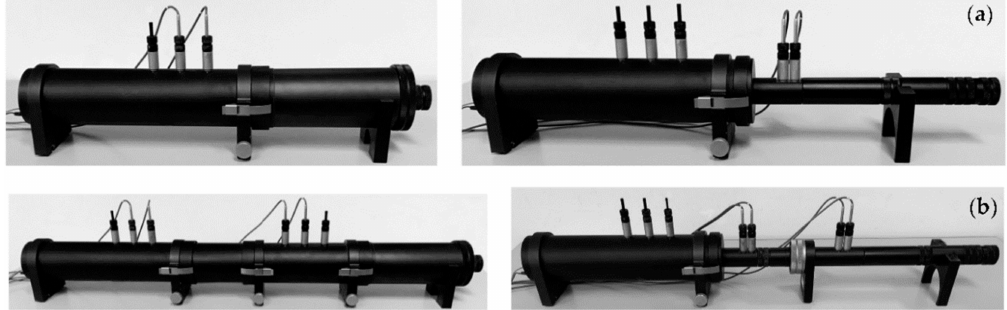
Figure 4. Normal incidence absorption coe ffi cient ( a ) and transmission loss ( b ) measurements: large (left) and small (right) tube